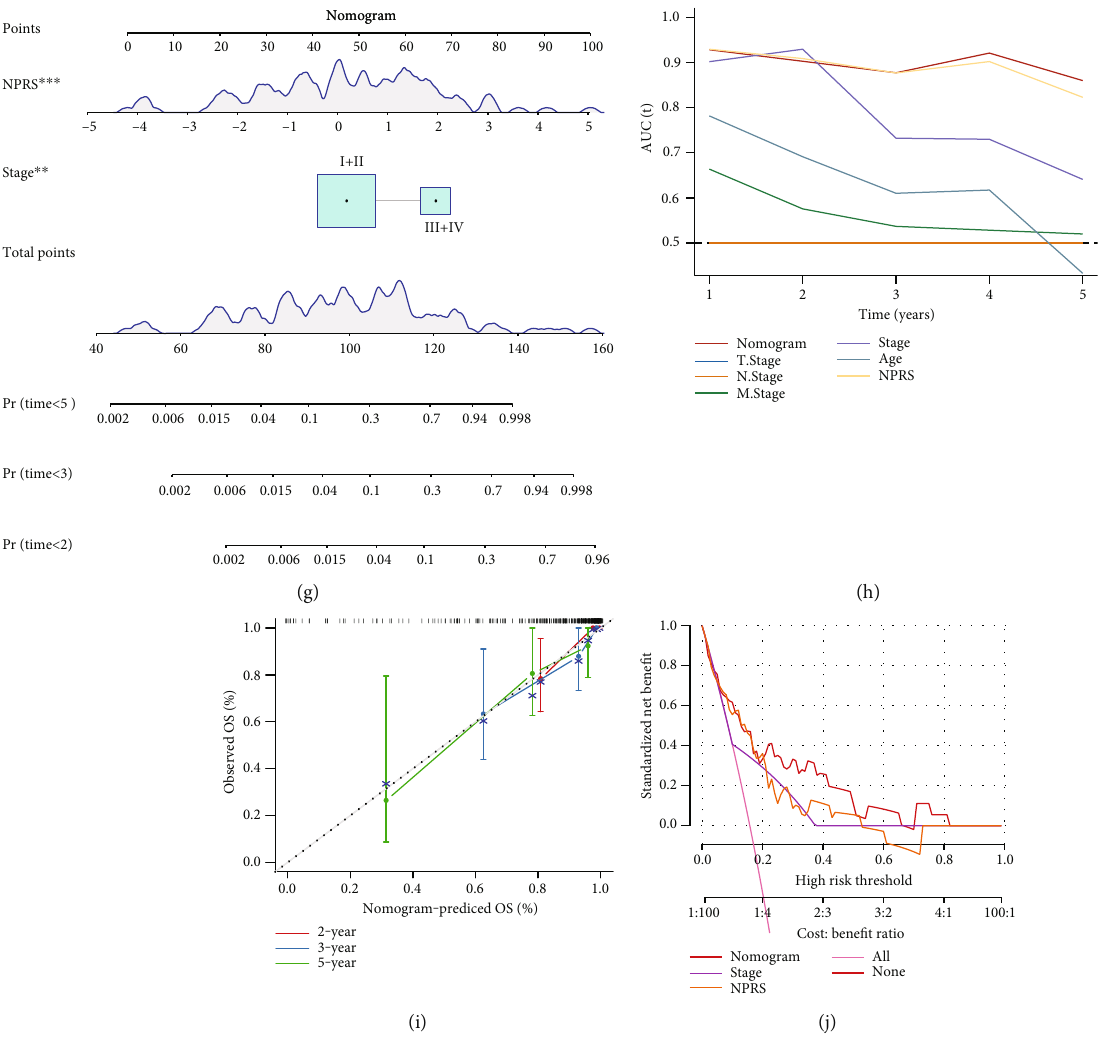
Figure 8: Nomogram of prognostic risk model in RNAseq data set combined with the clinical and pathological characteristics. (a) Patients with the full-scale annotations (RS, gender, age, and TNM Stage) were employed for constructing the survival decision tree and optimizing the risk strati fi cation. (b) Signi fi cant di ff erences noted in OS values noted in the 4 risk subgroups. (c, d) A comparative analysis between groups. (e, f) Univariate and multivariate Cox regression analyses of the RS and clinicopathological traits. (g) In comparison to the di ff erent clinicopathological features, the nomogram showed the highest capacity for OS prediction. (h) Nomograph model. (i) Calibration curve regarding nomograph in 2, 3, and 5 years. (j) Decision curve regarding nomograph. ns: no signi fi cance. ∗ p < 0 : 05 , ∗∗ p < 0 : 01 , ∗∗∗ p < 0 : 001 , and ∗∗∗∗ p < 0 : 0001